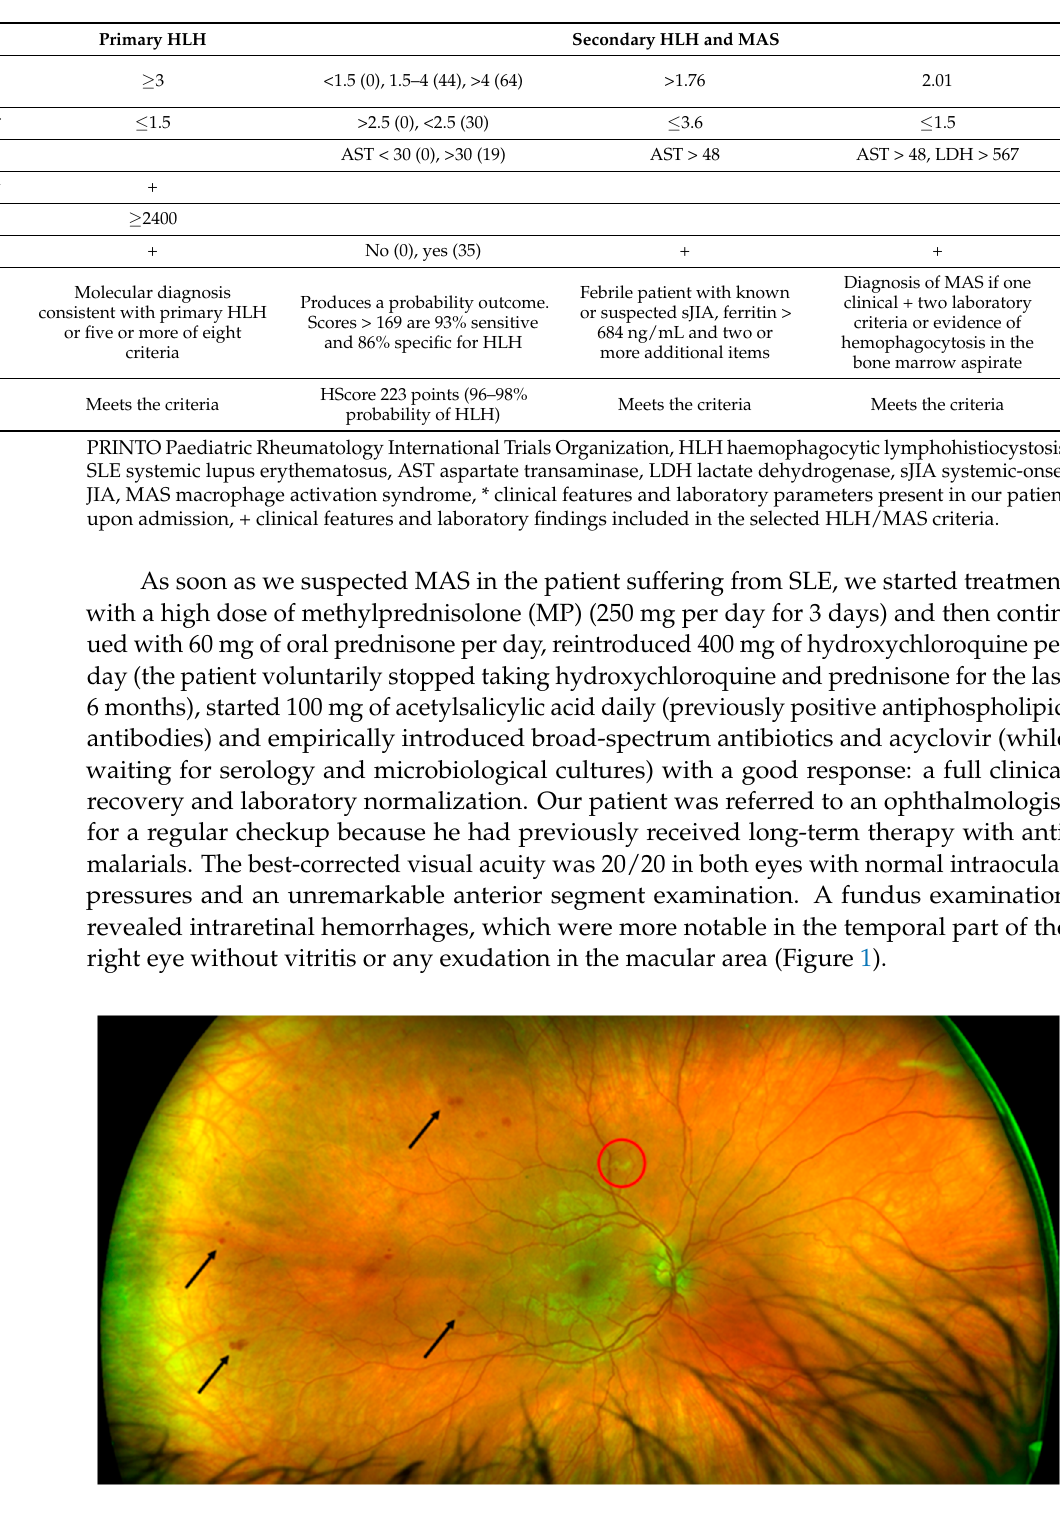
Figure 1. Fundoscopic examination of the right eye showing retinal vasculopathy with hemorrhages (arrows) and cotton wool exudate (red